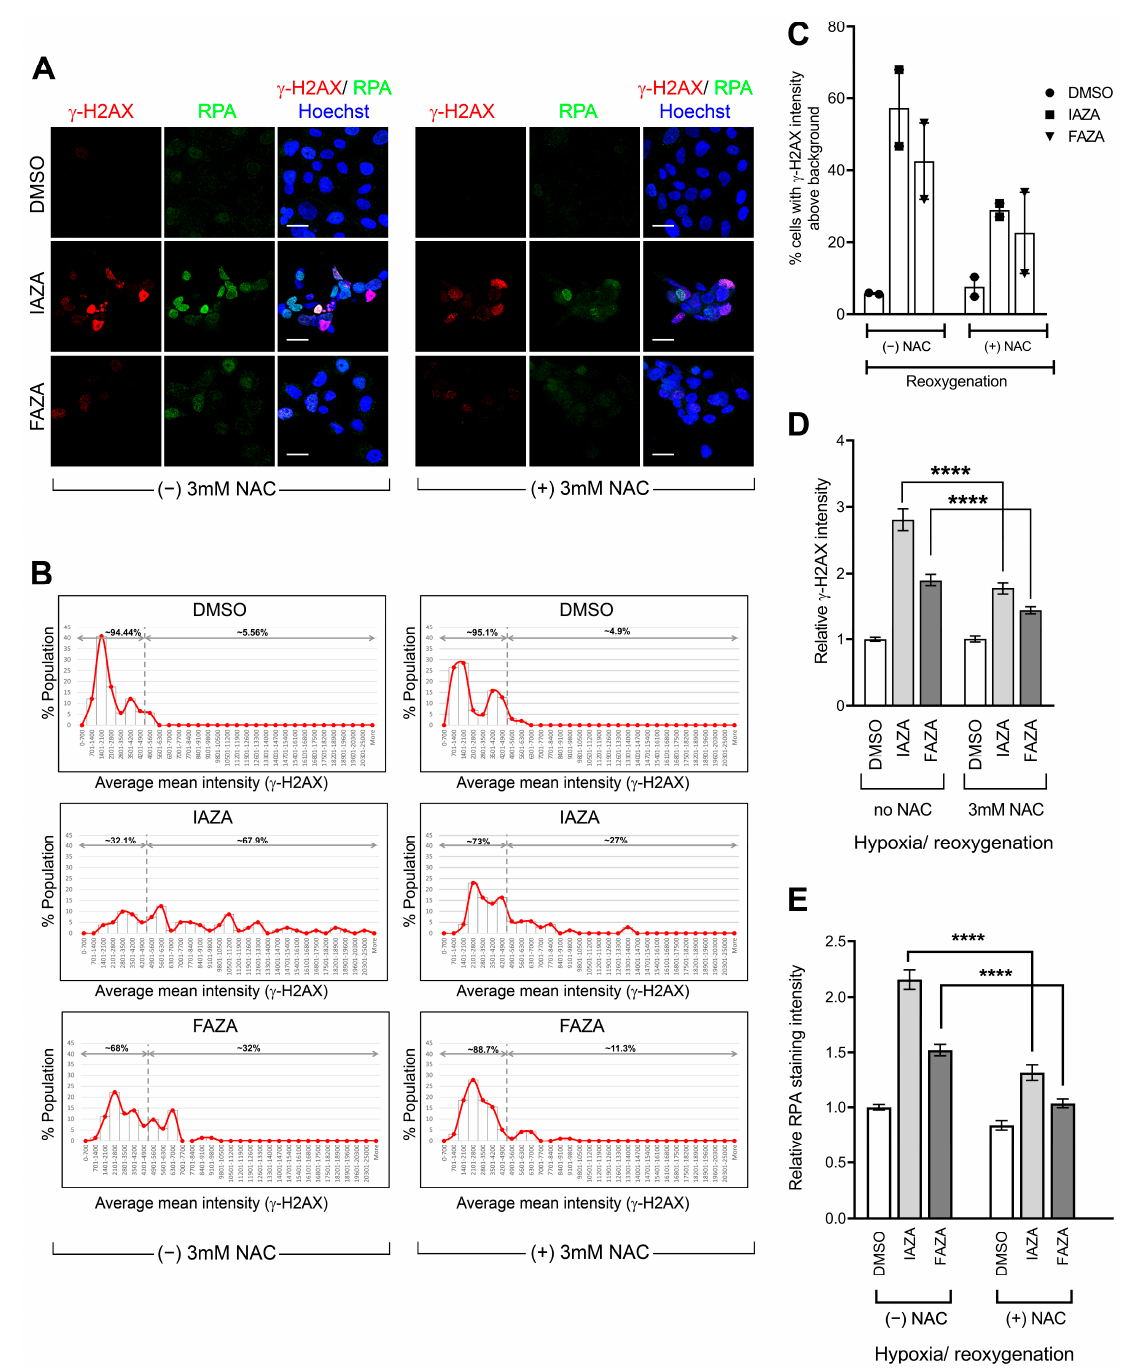
Figure 5. Reoxygenation in the presence of NAC reduced γ -H2AX and RPA-positive populations in drug-treated hypoxic cells. ( A ) Representative micrographs showing a reduction in γ -H2AX and RPA staining in response to NAC incubation during reoxygenation; scale bar = 20 µ m. ( B ) Representative histograms showing quantification of γ -H2AX staining intensity; dotted line shows the threshold for background levels of γ -H2AX staining. ( C ) Percentage of γ -H2AX-positive population in hypoxia/reoxygenated cells treated with IAZA or FAZA (100 µM) was decreased in the NAC-treated group; data show mean ± S.E.M. from two independent replicates. Quantification of γ -H2AX ( D ) and RPA ( E ) staining intensity are shown; a minimum of 125 cells were analyzed for each con- dition.